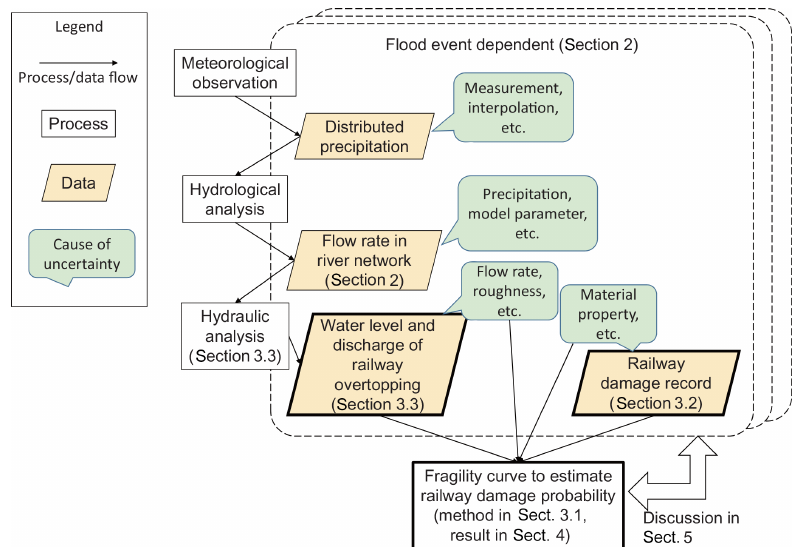
Figure 3. Relationship between processes and data within the structure of this